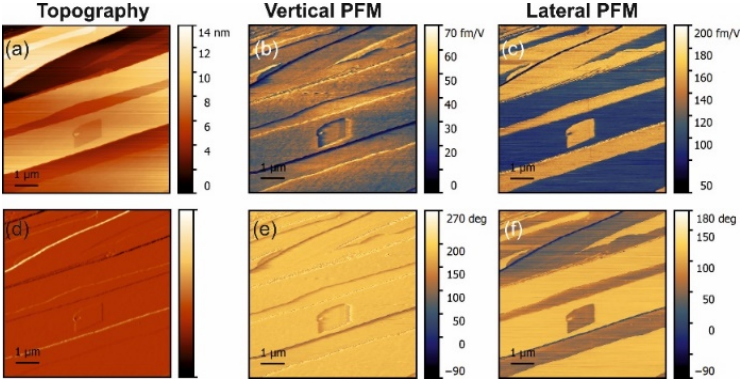
Figure 2. PFM measurements in threonine-doped glycine. ( a ) Topography and ( d ) deflection; ( b ) amplitude and ( e ) phase of the vertical piezoresponse; ( c ) amplitude and ( f ) phase of the lateral piezoresponse.